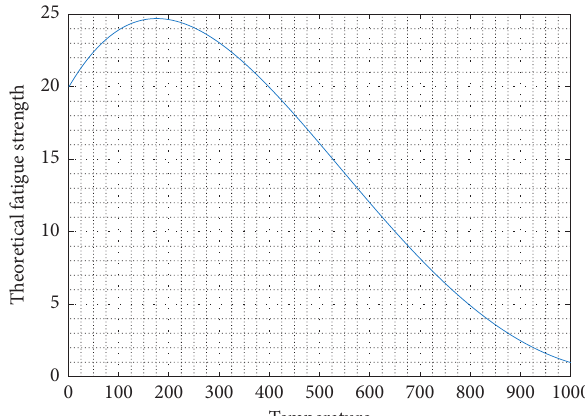
Figure 9: Theoretical fatigue strength v/s temperature for dis- similar materials.